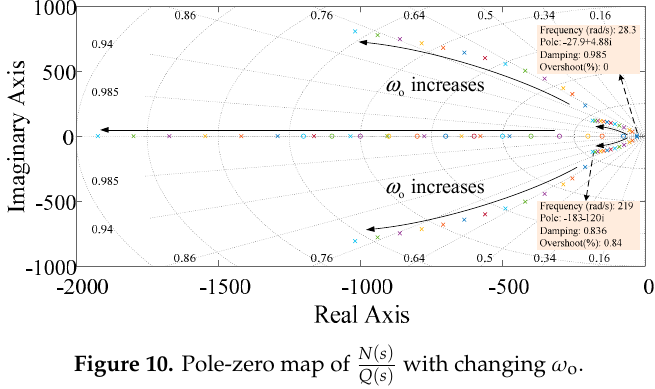
Figure 10. Pole-zero map of N